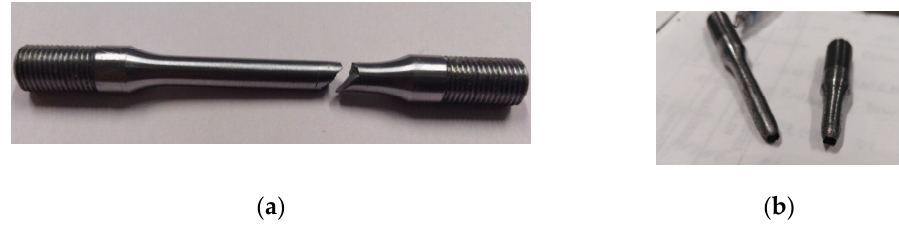
Figure 3. ( a ) Image of AISI 4145 smooth specimen tested in H 2 ; ( b ) Image of AISI 4145 smooth specimen tested in N 2